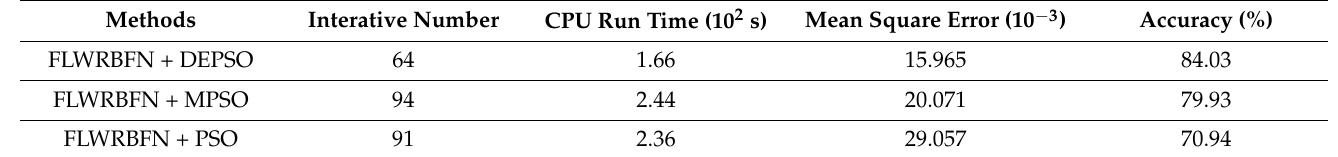
Figure 6. Convergence speed of the different algorithms under short circuit. Table 2. Quantitative comparison for several methods with short-circuits.